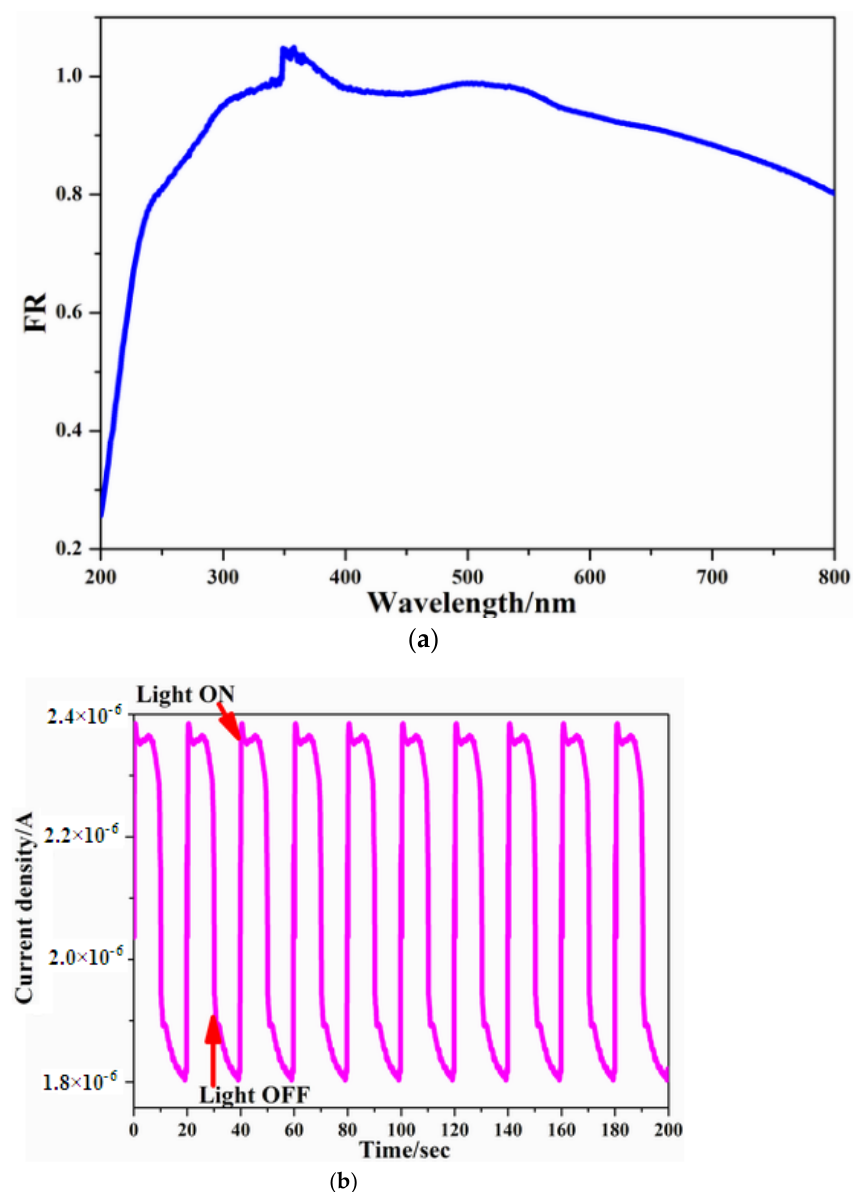
Figure 4. ( a ) Solid state electronic spectrum and ( b ) photocurrent response behavior of 1 .